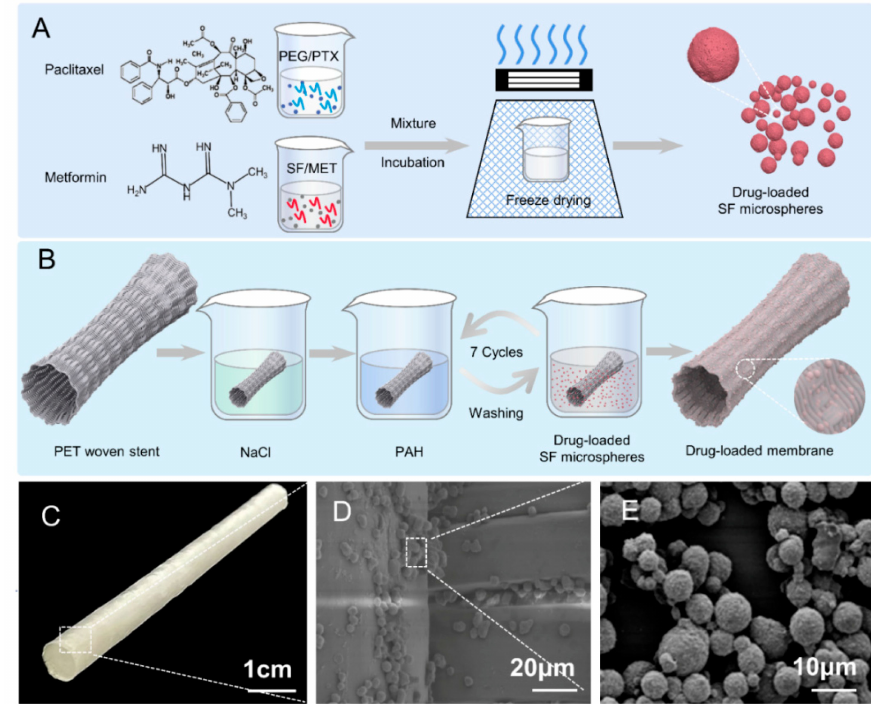
Figure 1. Schematic illustration of preparation and evaluation of stent-graft fabrics. ( A ) Preparation flow chart of drug-loaded SF microspheres. ( B ) Preparation flow chart of drug-loaded SF micro- spheres stent-graft. ( C ) Photography of woven vascular stent-grafts modified with drug-loaded SF microspheres. ( D ) SEM image of drug-loaded SF microspheres coated on the woven vascular stent. ( E ) SEM image of drug-loaded SF